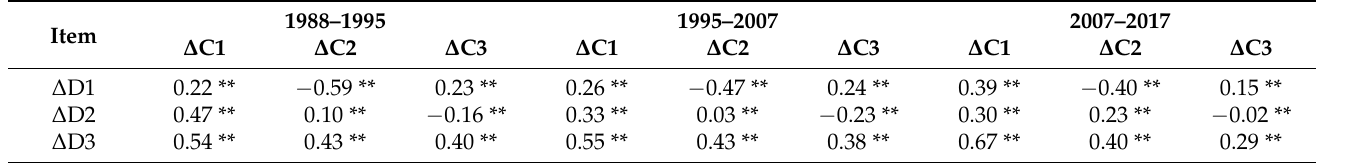
Table 2. Partial correlation coefficients of variations of components with those of